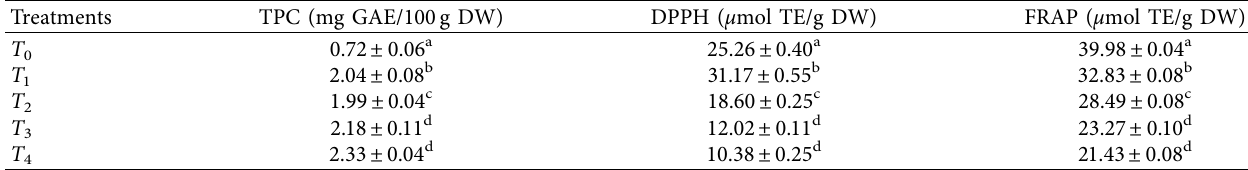
Values are means ± standard deviation of triplicate determinations ( n � 3); a − d means followed by diferent letters in a column are signifcantly diferent ( p < 0 . 05). T 0 � 100% WWF-based value added bread, T 1 � control—2.5% MLP-based value added bread, T 2 � 5% MLP-based value added bread, T 3 �